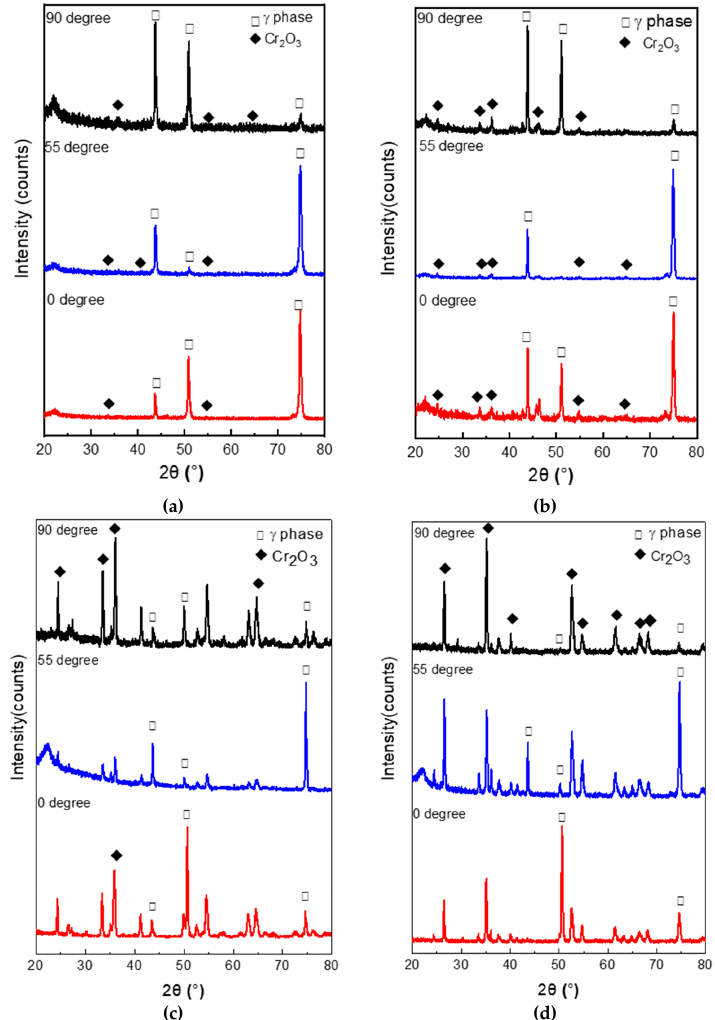
Figure 11. XRD patterns of the three alloys after oxidation at ( a ) 700 °C for 4 h; ( b ) 700 °C for 100 h; ( c ) 1000 °C for 4 h, and ( d ) 1000 °C for 100 h. ( c ) 1000 ◦ C for 4 h, and ( d ) 1000 ◦ C for 100